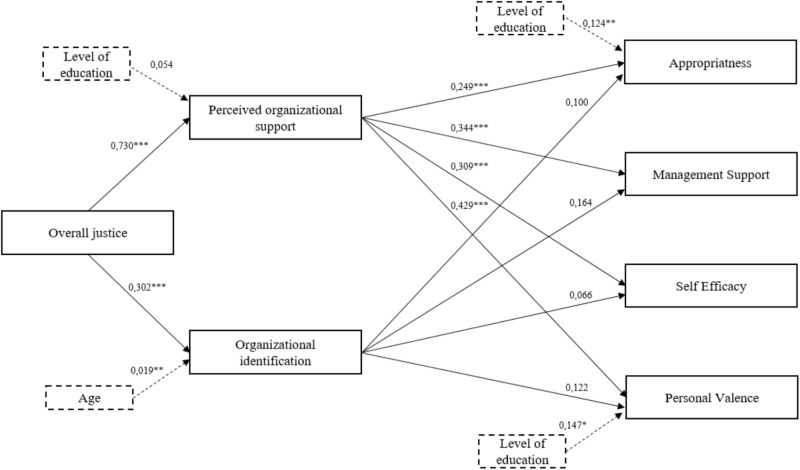
Dotted lines are used to represent the effects of control variables. (N = 145).χ2(13) = 15.42, p = 0.28; RMSEA = 0.04; CFI = 0.99: CFI = 0.96; SRMR = 0.037. ∗p < 0.05, ∗∗p < 0.01, and ∗∗∗p < 0.001.